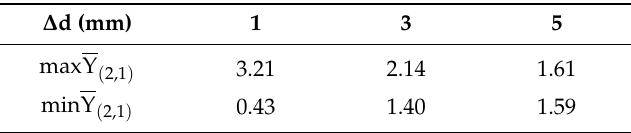
Table 1. Average Y ( 2,1 ) over ∆